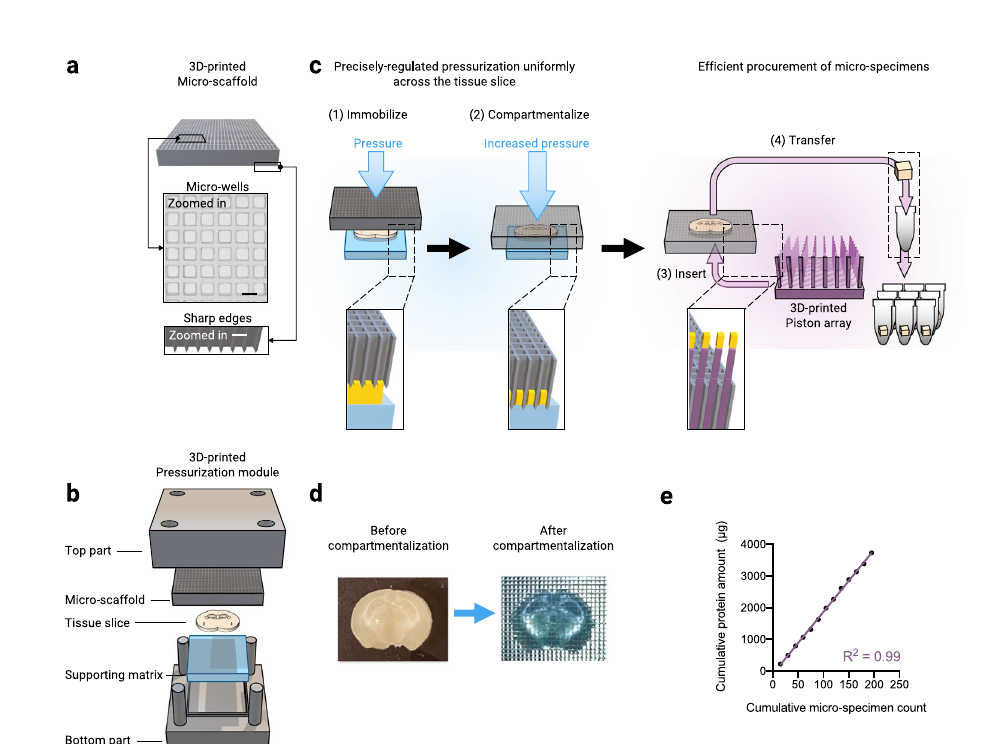
Fig.2|Thework fl owforprecisemicro-compartmentalizationofthetissueand the procurement of spatially resolved micro-specimens. a The 3D-printed micro-scaffold with narrow edges to achieve precise tissue compartmentalization (scale bar: 400 µ m). b The assembly of the 3D-printed pressurization module with the stack of micro-scaffold, tissue slice, and the supporting matrix (from upper to lower), to enable precisely-regulated and uniform pressurization across the entire tissue slice. The detailed pressurization procedure is shown in Supplementary Movie 1. c The schematicprocedurefor robust tissue micro-compartmentalization followed by ef fi cient procurement of micro-specimens. A precisely-regulated pressureisappliedonthemicro-scaffold,whichuniformlyimmobilizes(1)andthen compartmentalizes the tissue slice with elevated pressure (2). Next, a 3D-printed